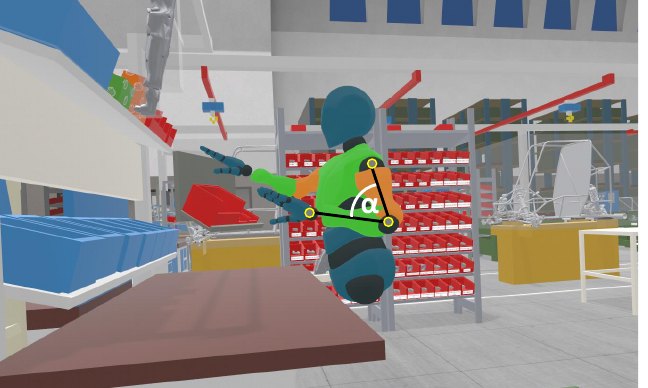
Figure 1. An avatar which performs movements at a virtual workplace. An exemplary representation of the relevant joint positions for the determination of the joint angle of the elbow